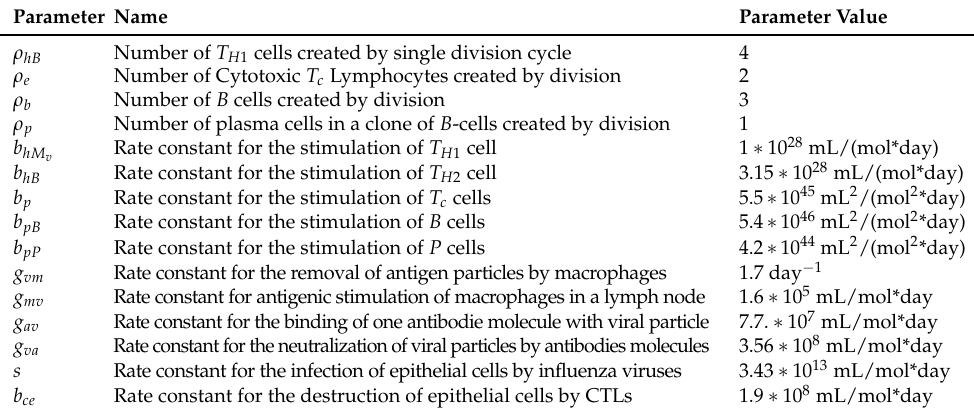
Table 3. Parameters used in the model (continuation).